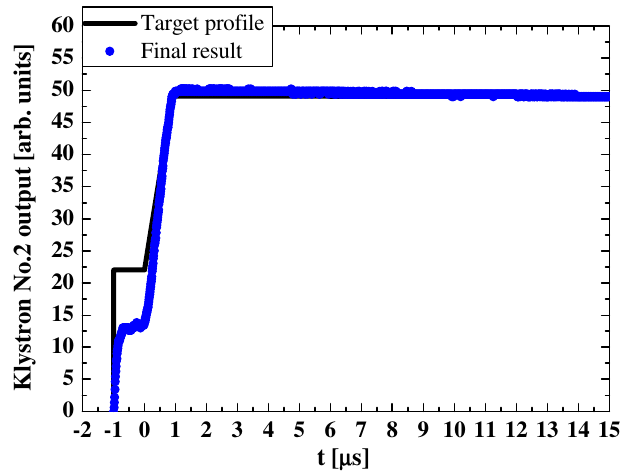
FIG. 13. (Color) Final result of output and target profile (ampli- tude profile) of klystron 2.